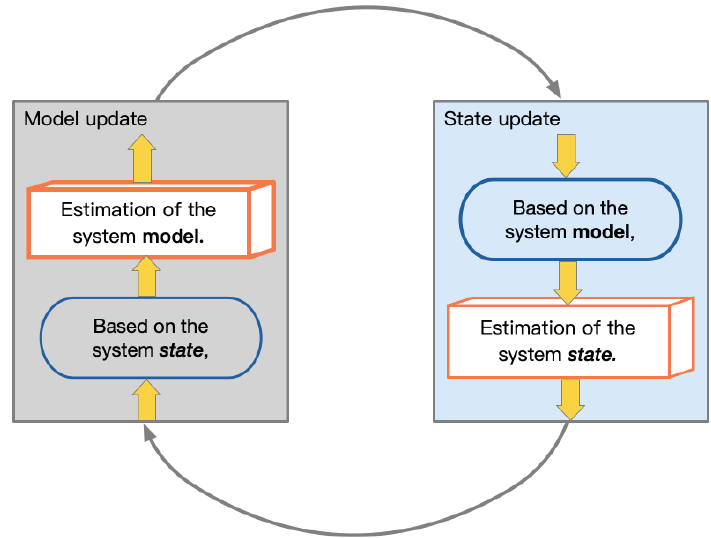
Figure 3. The optimization loop of the system model and state.